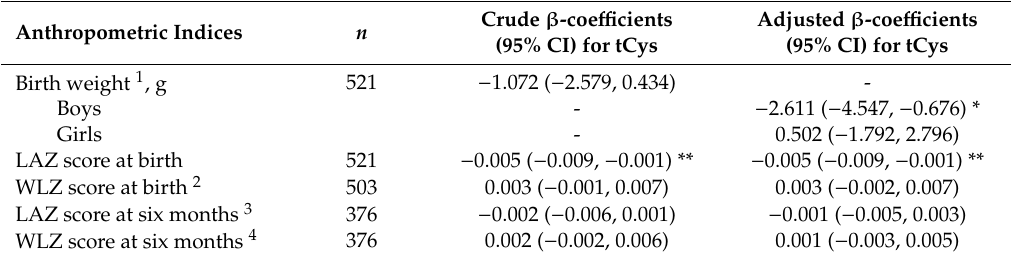
Table 2. Multivariate linear regression models for anthropometric measurements and maternal plasma total cysteine (tCys) concentration (in µ mol /